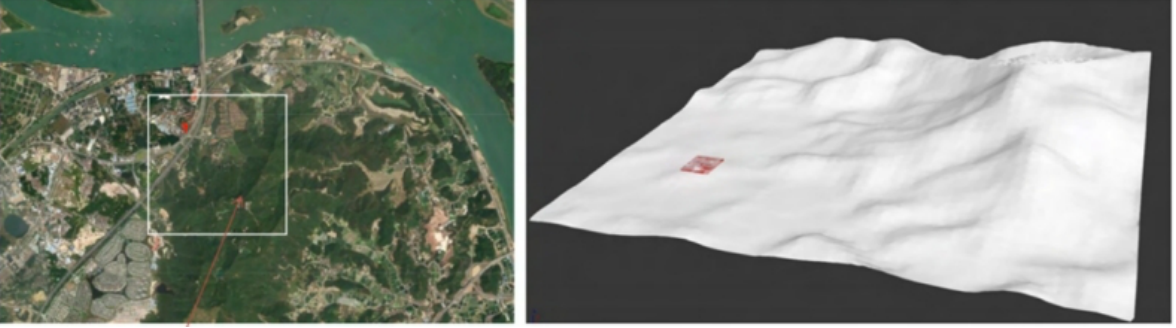
Figure 4. Summer winds are blocked by the southeasterly Great Wild Goose Mountains, with overall southerly winds.